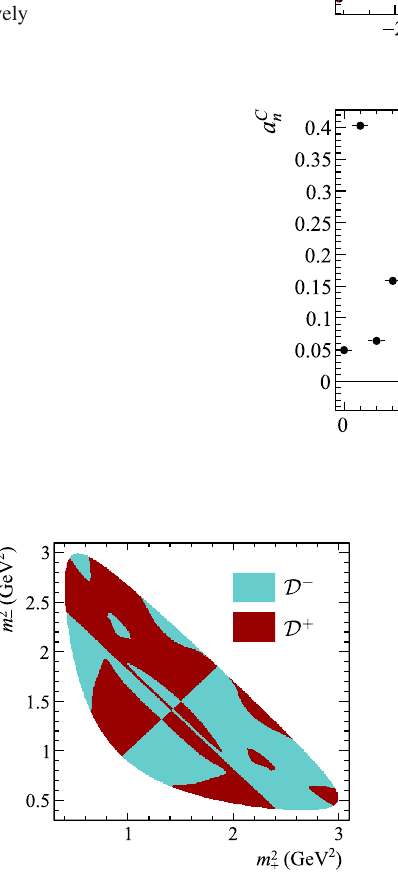
Fig. 4 Splitting of D → K 0 D −